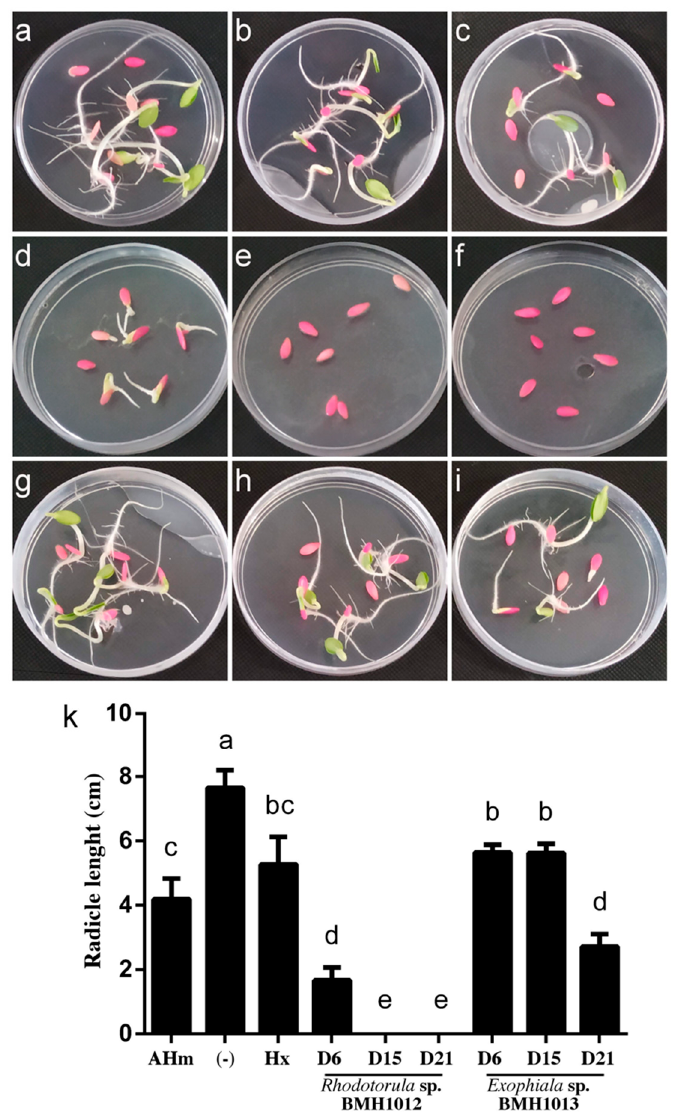
Figure 7. E ff ect on the germination and the radicle length of C. sativus seeds after treatment with extracts from supernatants of media with hydrocarbons treated by strains BMH1012 (D6, D15, and D21) and BMH1013 (D6, D15, and D21). ( a ) Crt-, agar with distilled water. ( b ) Agar with 20% hexane. ( c ) Control of agar with aromatic hydrocarbon mixture (AHm, see material and methods section), ( d ) Day 6, ( e ) D15, and ( f ) D21 supernatants from the culture of Rhodotorula sp. BMH1012 with AHm as a carbon source added to agar. ( g ) Day 6, ( h ) D15, and ( i ) D21 supernatants from the culture of Exophiala sp. BMH1013 with AHm as a carbon source added to agar. ( k ) Radicle length of seedlings growing on treatments as described above. Data is presented as the average amount of aromatic hydrocarbon remaining in the media (%) ± standard deviation (error bars). Letters indicate levels of significance and statistical di ff erences. ANOVA p -value < 0.05.